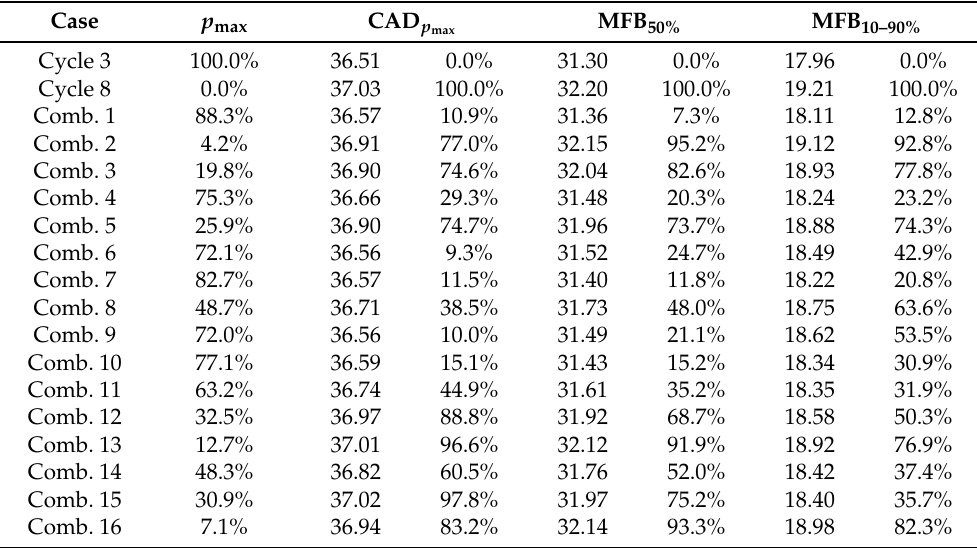
Table 2. Normalized maximum pressure, CAD after ignition of its occurrence, CAD after ignition of the mass fraction burnt 50% and combustion duration (MFB 10–90% ).